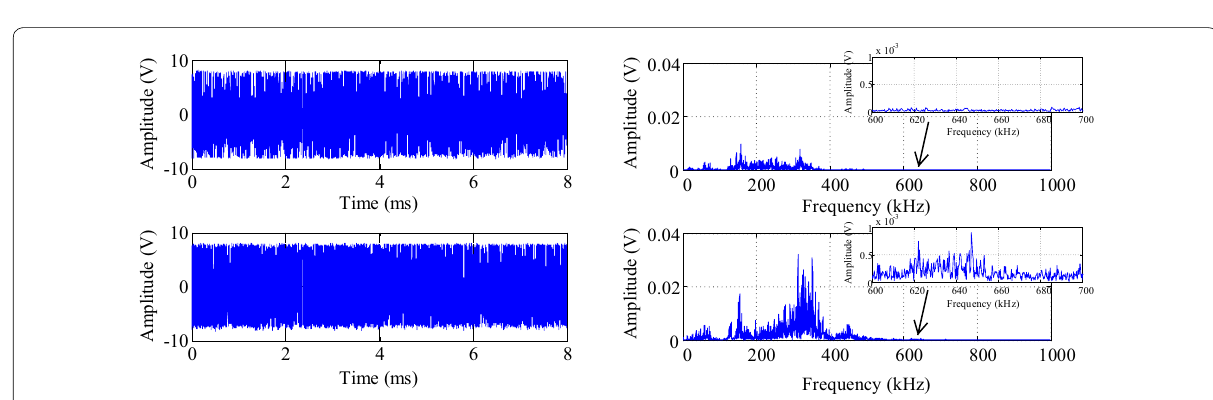
a Waveforms of no-burn and burn grinding signal Figure 5 AE signals produced by grinding process